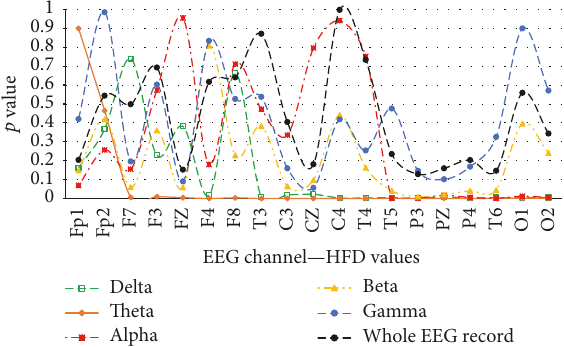
Figure 6: 𝑝 values for HFD between AD patients and normal subjects of the training EEG dataset.